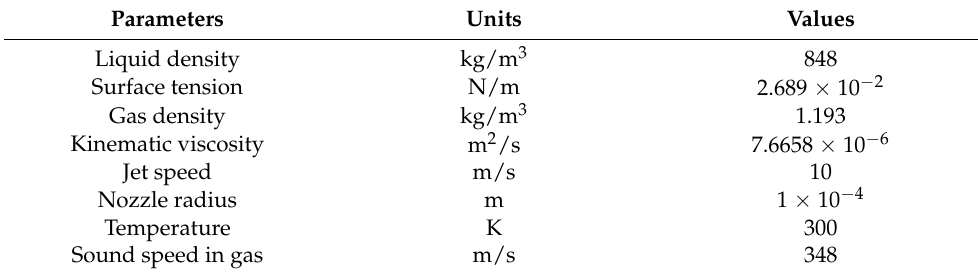
Table 1. Calculating